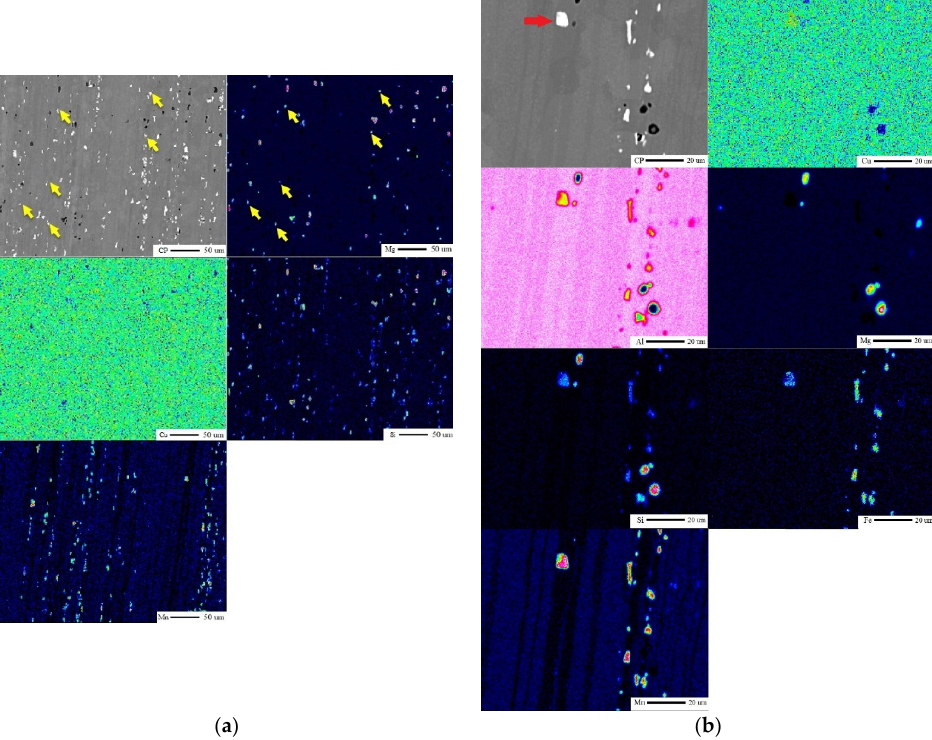
Figure 5. TEM photo show the plate ‐ shape and lump ‐ shape precipitate in the matrix of ( a ) T6 sample, and ( b ) CFT6a sample.